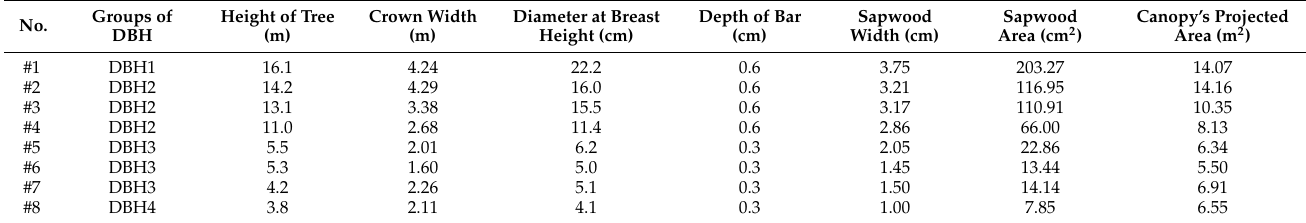
Table 1. Biometric and physiological parameters of the sap flow measurement trees.